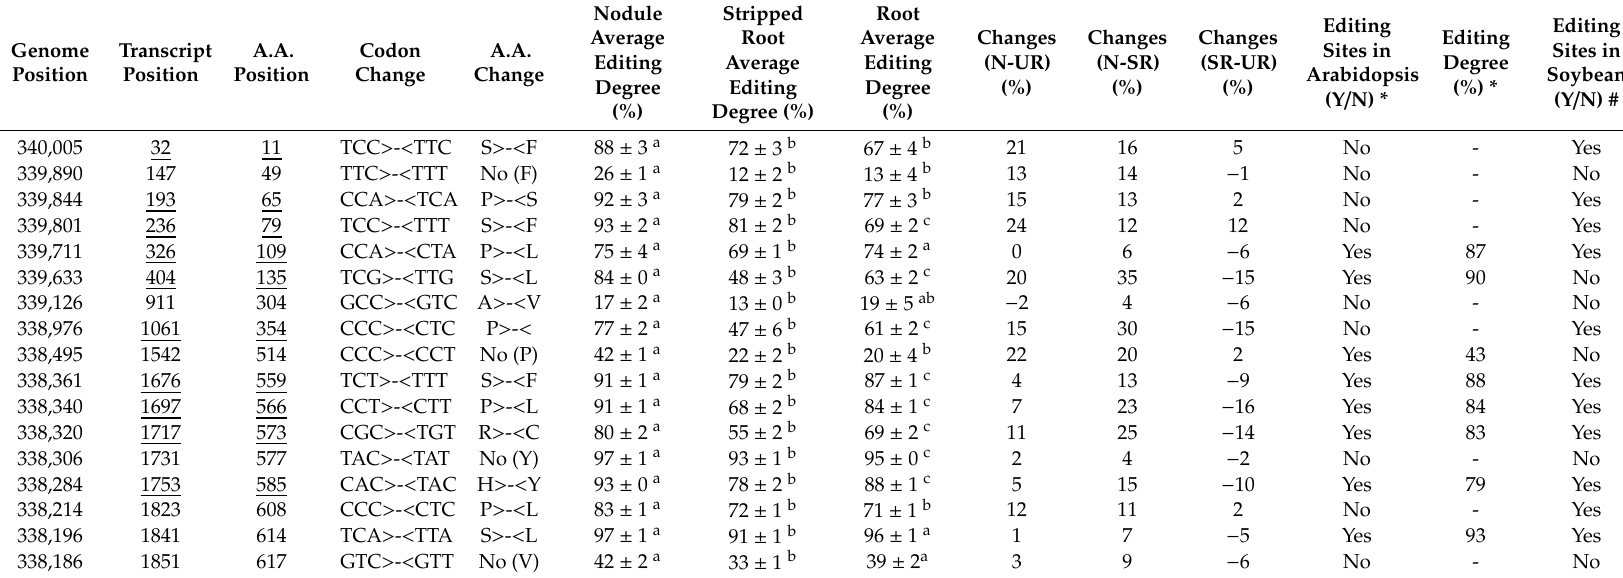
Table 3. RNA editing sites in matR